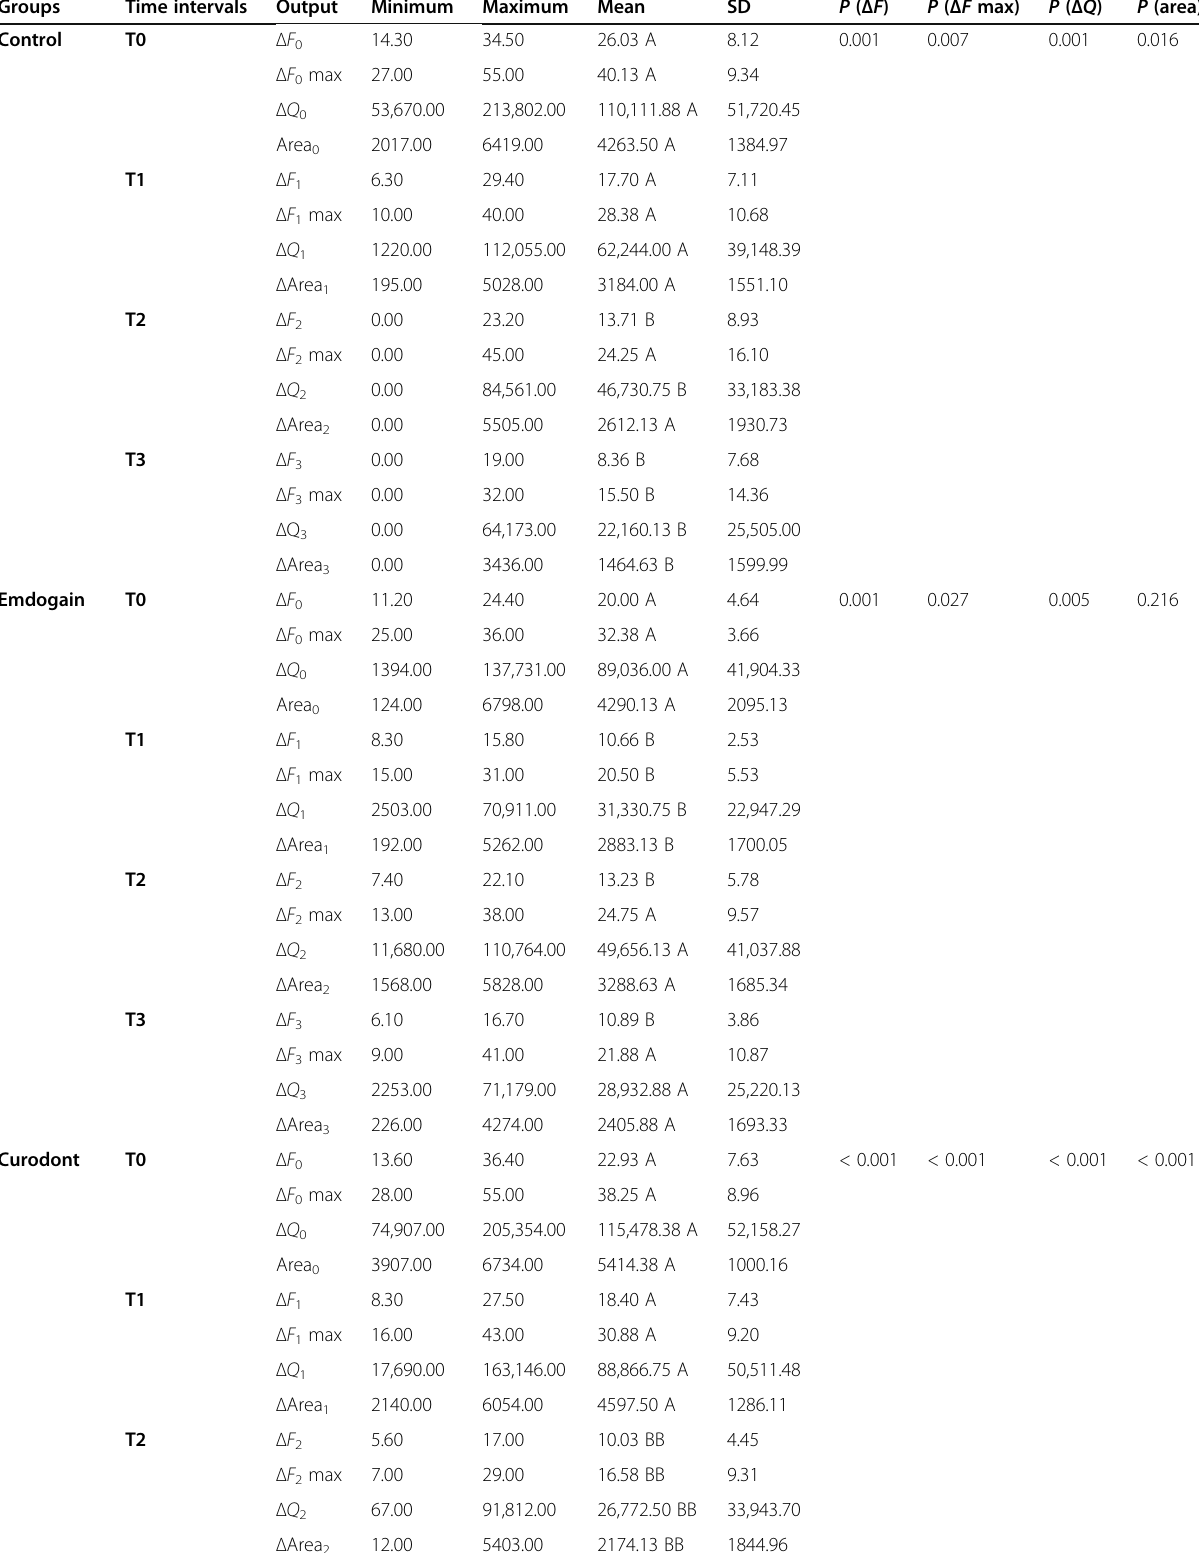
Table 2 Intragroup comparisons of QLF scores between timeline intervals